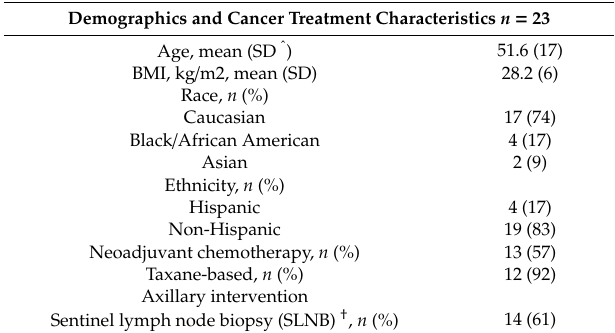
Table 1. Patient